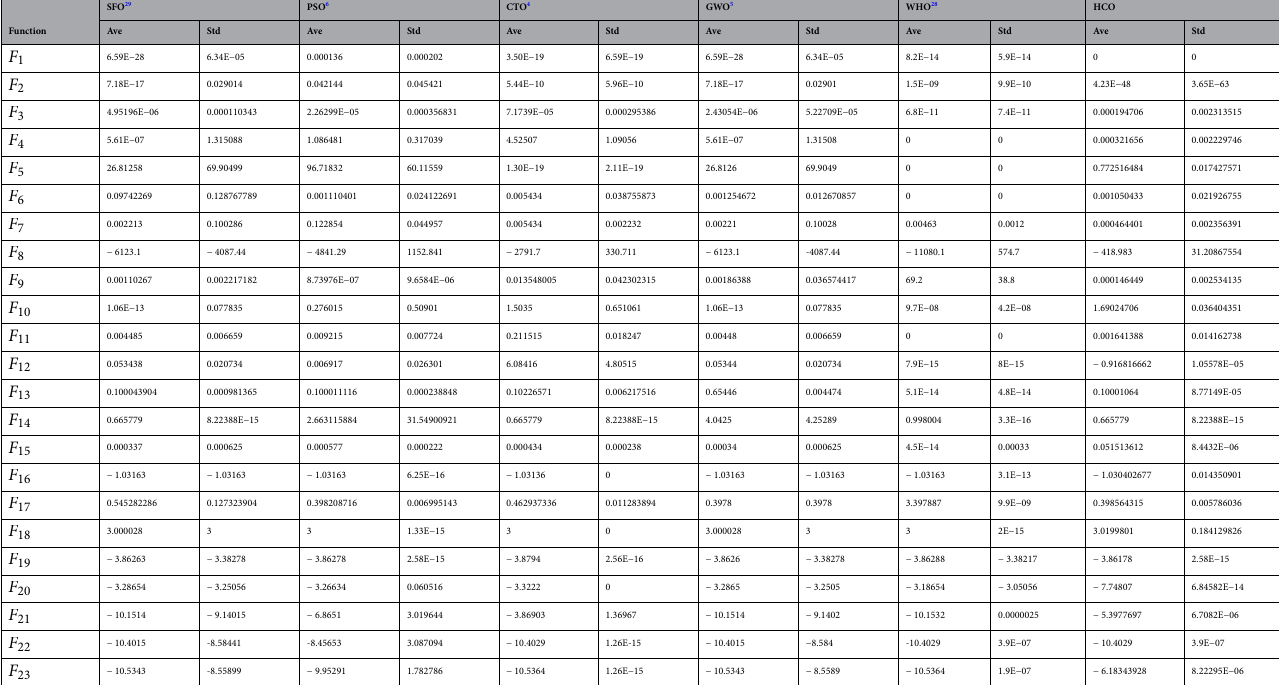
Table 3. Convergence performance comparison for CEC 2005 benchmark